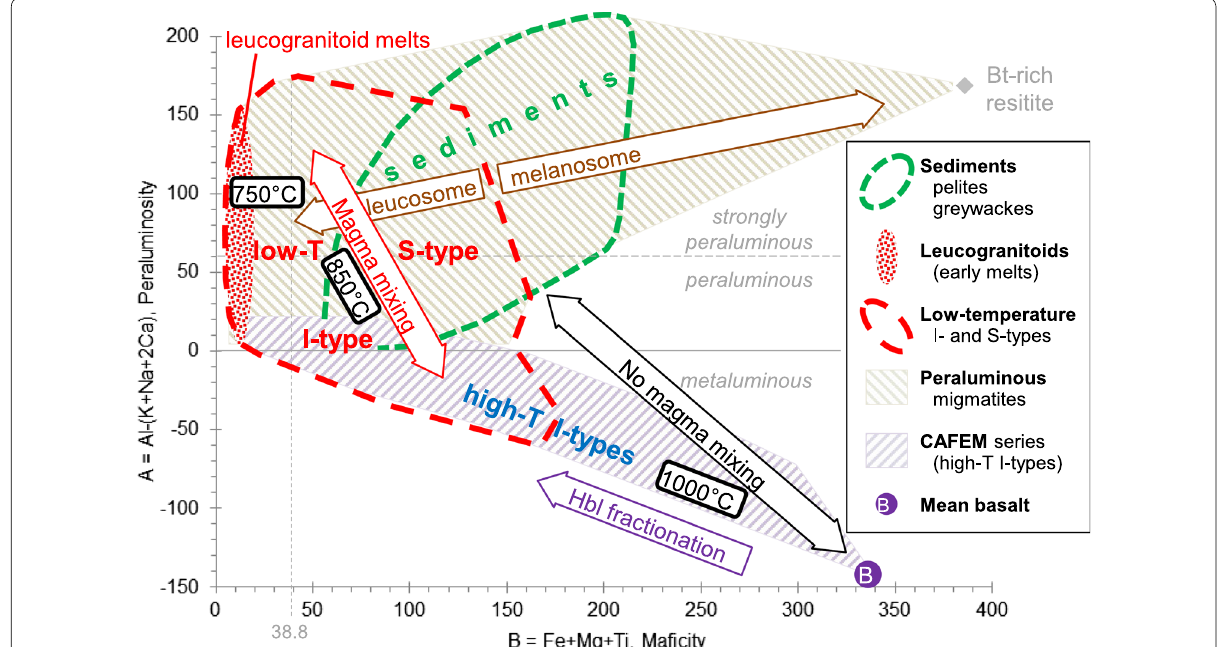
Fig. 10 A-B diagram (Debon and Le Fort 1988) with indicated sources of material and heat and magmatic processes (as listed with references in Table 3) for the genesis of peraluminous arc magmatism in subduction–accretion-complexes. For explanations see